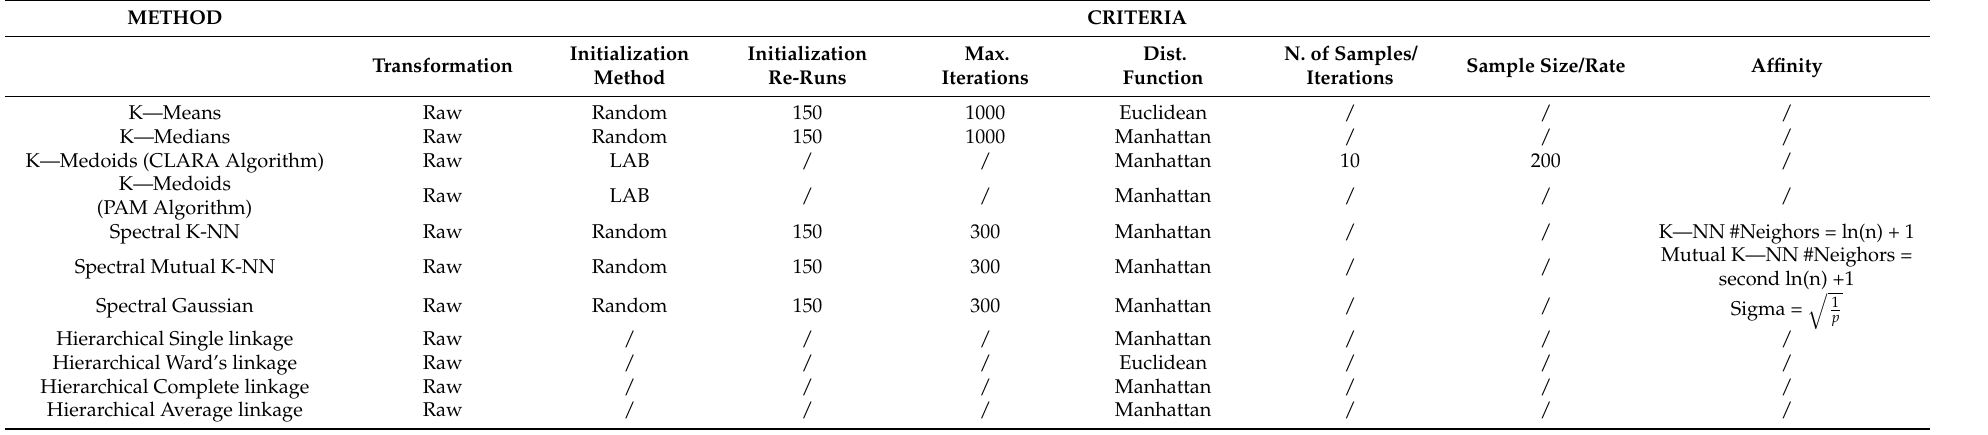
Table 2. Criteria of the clustering algorithms. The “/” symbol indicates that the setting is absent for the specified algorithm. The ability of the single algorithms to form two different clusters (urbanized areas and not-urbanized areas) from the datasets were evaluated through the ratio of the total between-groups sum of squares (BSS) to the total sum of squares (TSS), or the “BSS/TSS” metric. As the value becomes higher, the cluster separation becomes